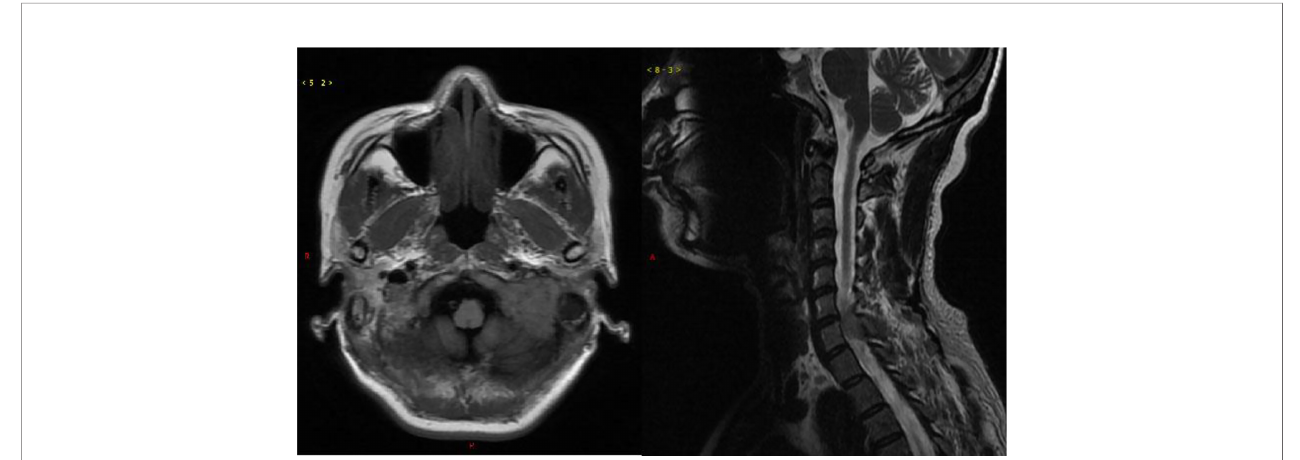
FIGURE 1 | Magnetic resonance imaging of the brain and spine. Left, axial T1 weighted; right, sagittal T2 weighted.